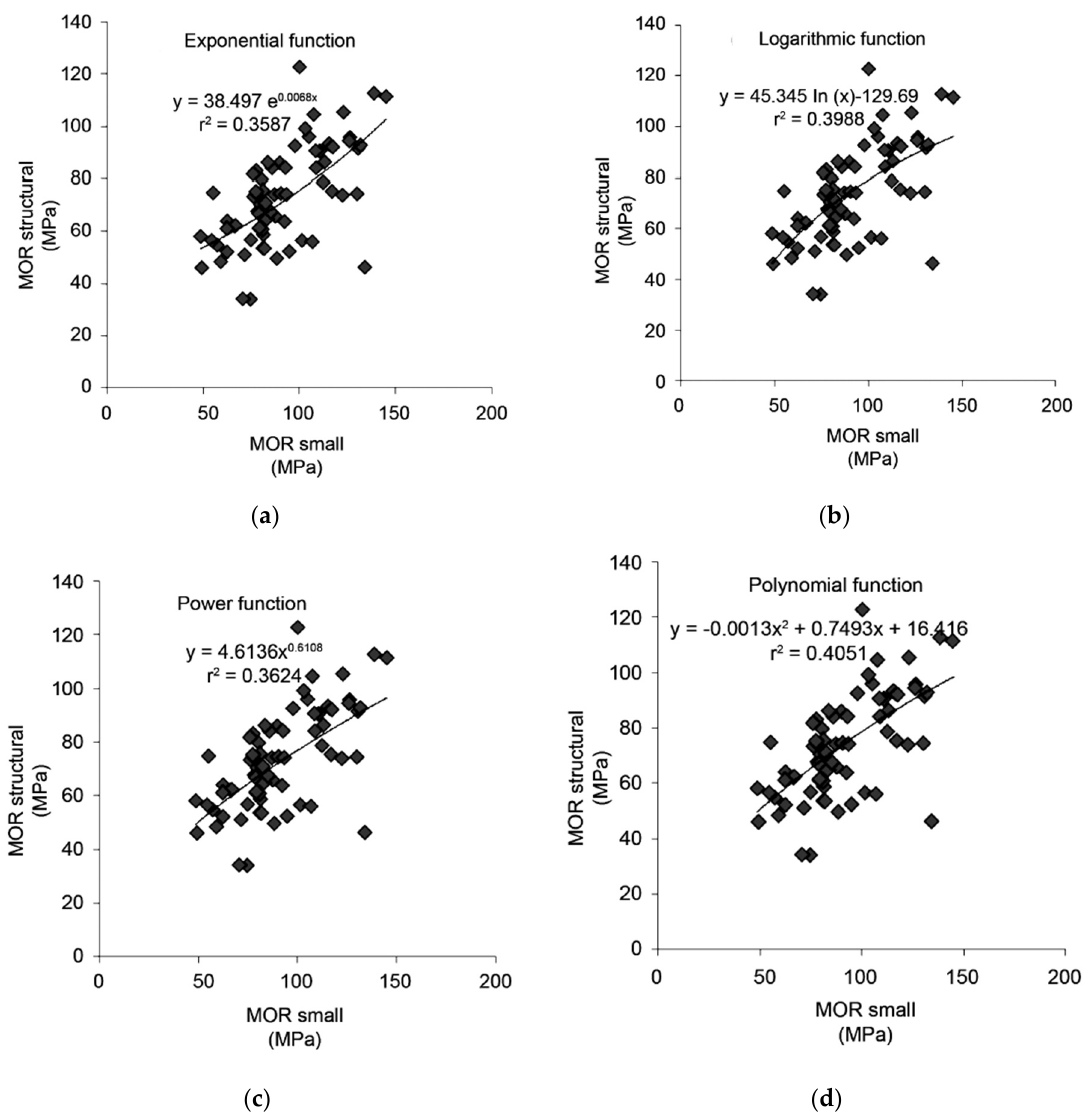
Figure 33. Plots of data obtained for modulus of rupture (MOR) for specimens of structural size against MOR for small specimens of mixed hardwoods. The lines in each plot represent various functions of structural size. ( a ) Exponential; ( b ) logarithmic; ( c ) power; ( d ) polynomial. From [160].